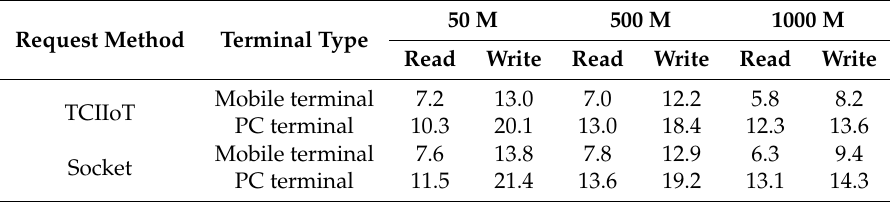
Table 6. The speed of reading and writing results